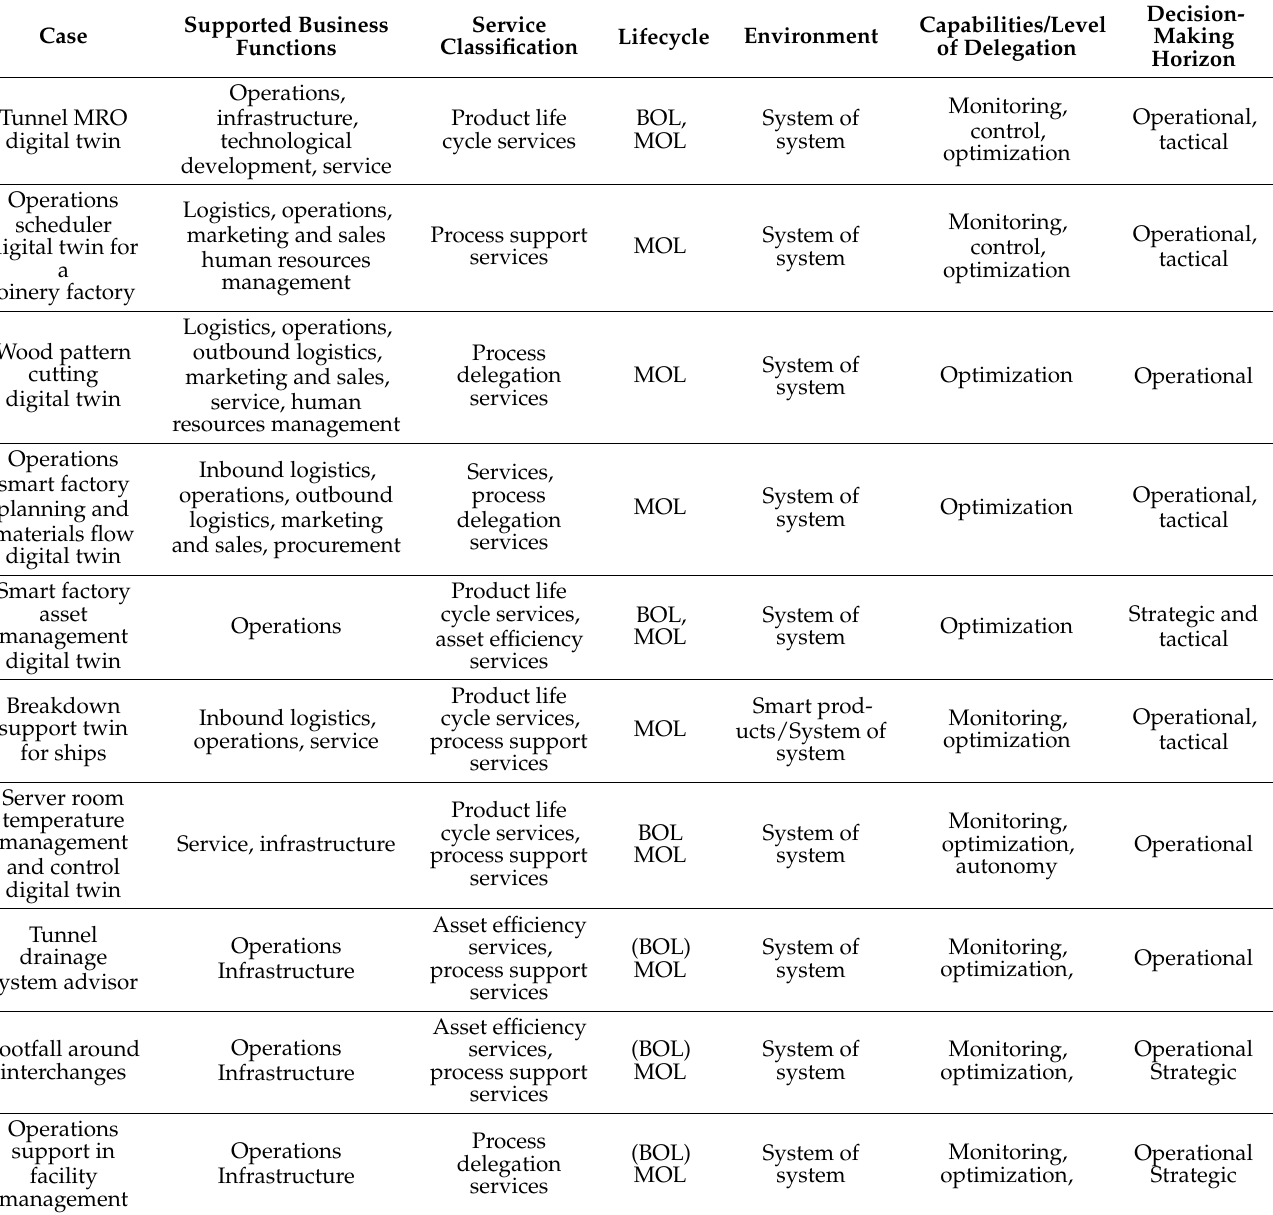
Table 3. Classification of the ten use